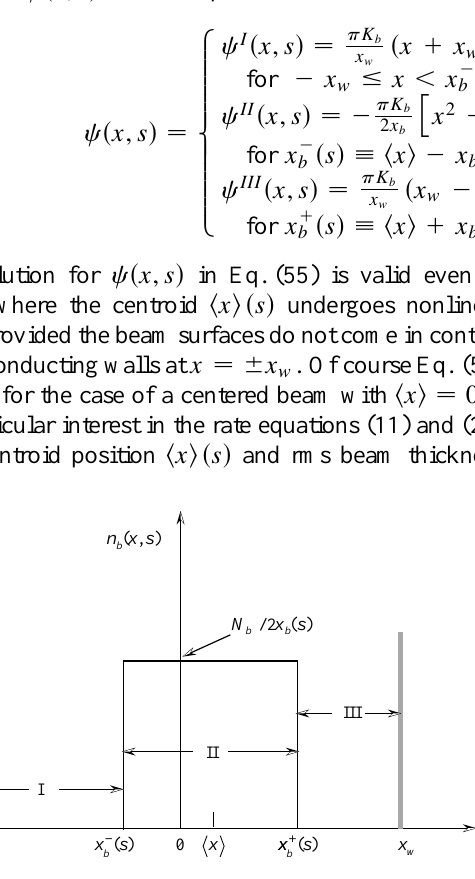
FIG. 3. Plot versus x of the step-function density profile n b (cid:1) x , s (cid:2) in Eq. (42) corresponding to the parallelogram distri- bution in Eq. (40) and Fig. 2. Here, n b (cid:1) s (cid:2) (cid:1) N b (cid:3) 2 x b (cid:1) s (cid:2) , and the density profile is centered at x (cid:1) (cid:7) x (cid:8) (cid:1) s (cid:2)